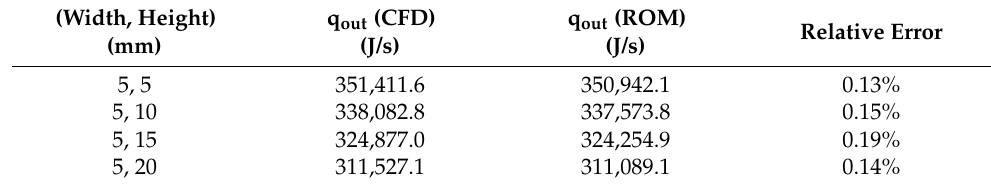
Table 4. Predictions results of absorber tube for four fin geometries with fin adjacent angle of 45 ◦ . (Width, Height) (mm)